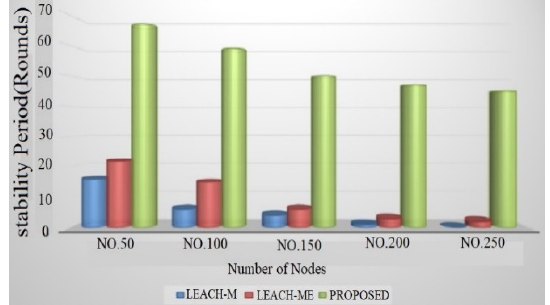
Fig. 16. Number of moments CH flops in transmission against the number of rounds.